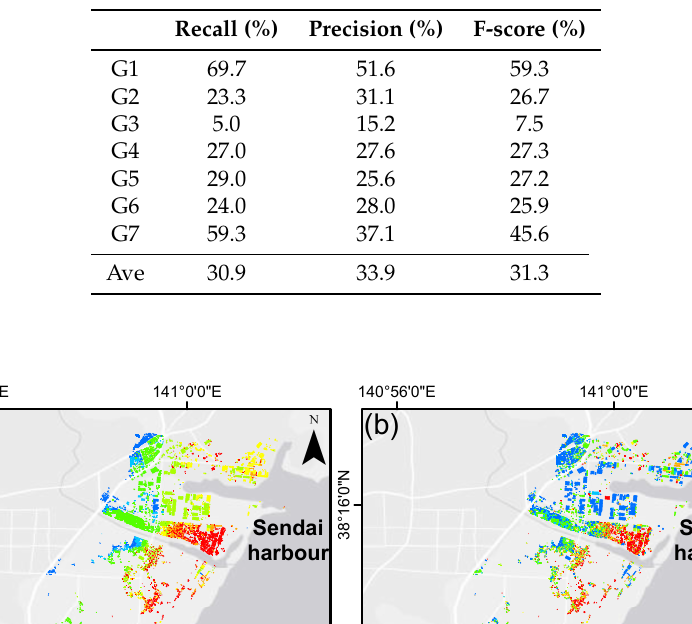
Table 6. Accuracy evaluation of seven-class classification.